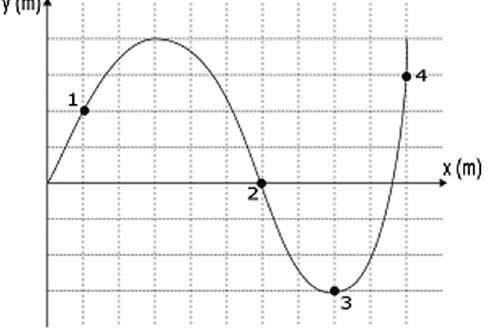
FIG. 3. Solving question (a) by drawing